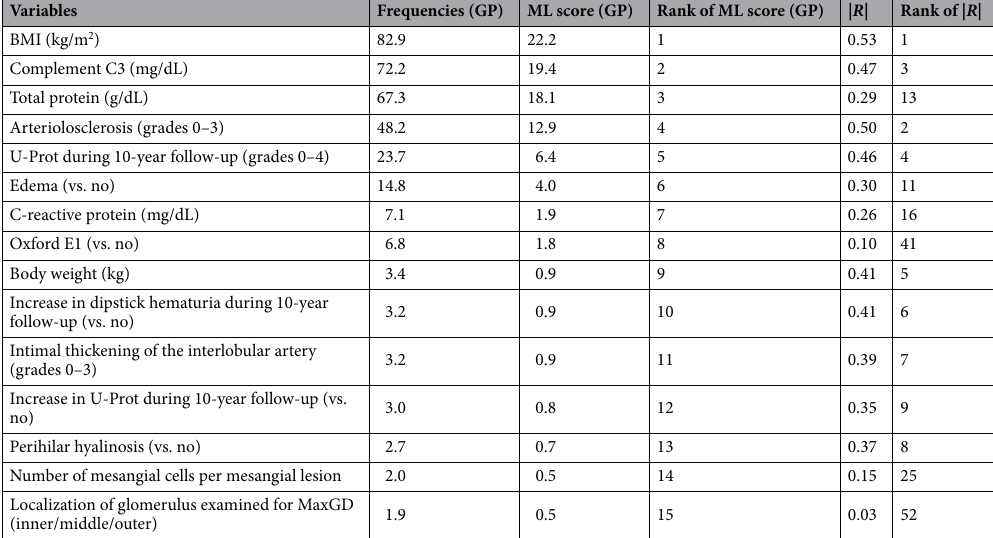
Table 2. Top 15 variables in machine learning score via genetic programming [ML score (GP)] in association with the MaxGD ≥ 242.3 μm. The Frequencies (GP) values, The ML score (GP) values, ML score (GP) ranks, | R | values, and | R | ranks for each variable are listed. The rankings in ML scores (GP) and Frequencies (GP) have the same results. |R| is the absolute value of point-biserial r (Supplemental Fig. 1). Abbreviations: ML, machine learning; GP, genetic programming; MaxGD, maximal glomerular diameter; point-biserial r , point- biserial correlation coefficient; BMI, body mass index; C3, component 3; U-Prot, Urinary protein excretion; Oxford E1, the presence of endocapillary